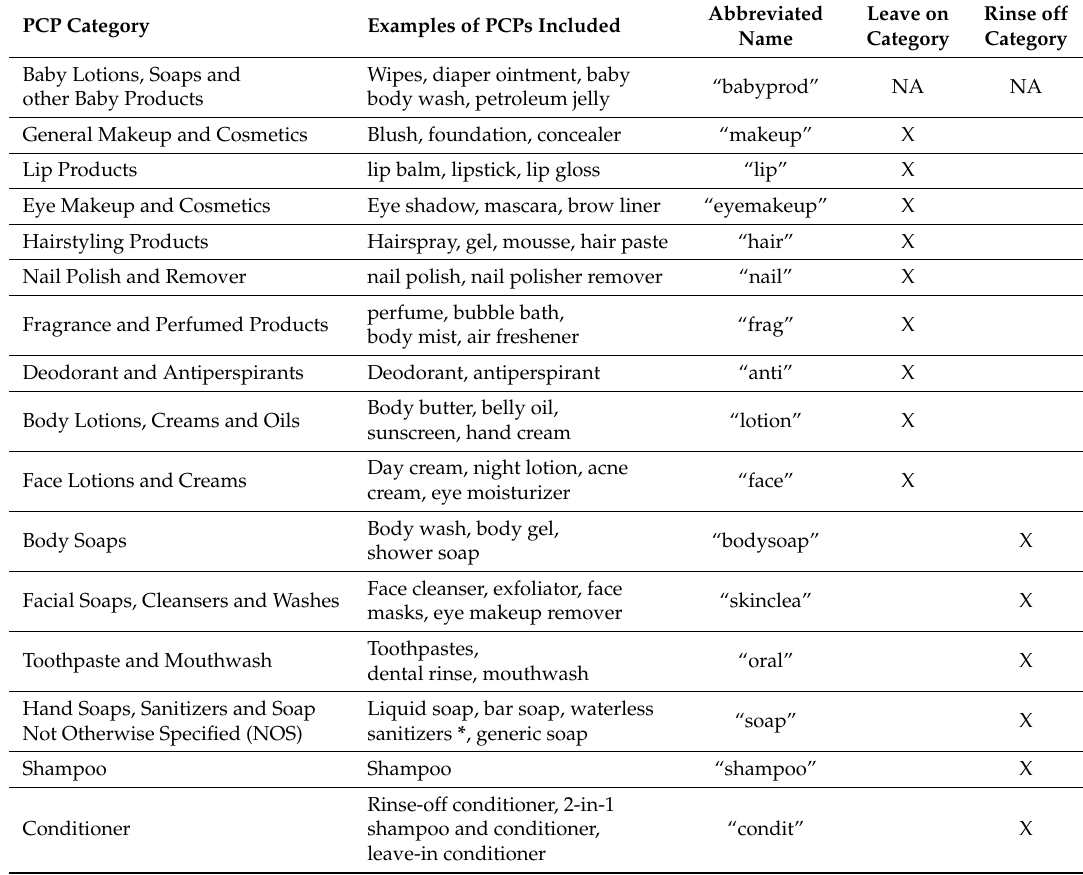
Table 1. Personal care products (PCP) categories used and examples of PCPs within each category. PCP